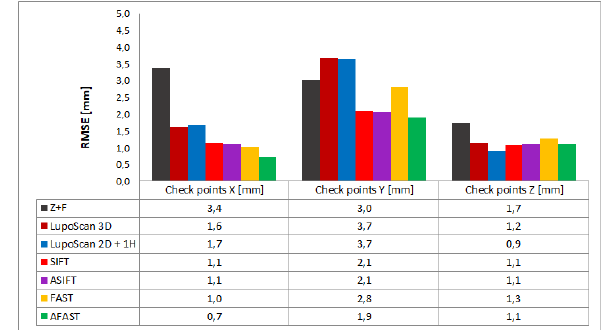
based on reliability matrix analysis